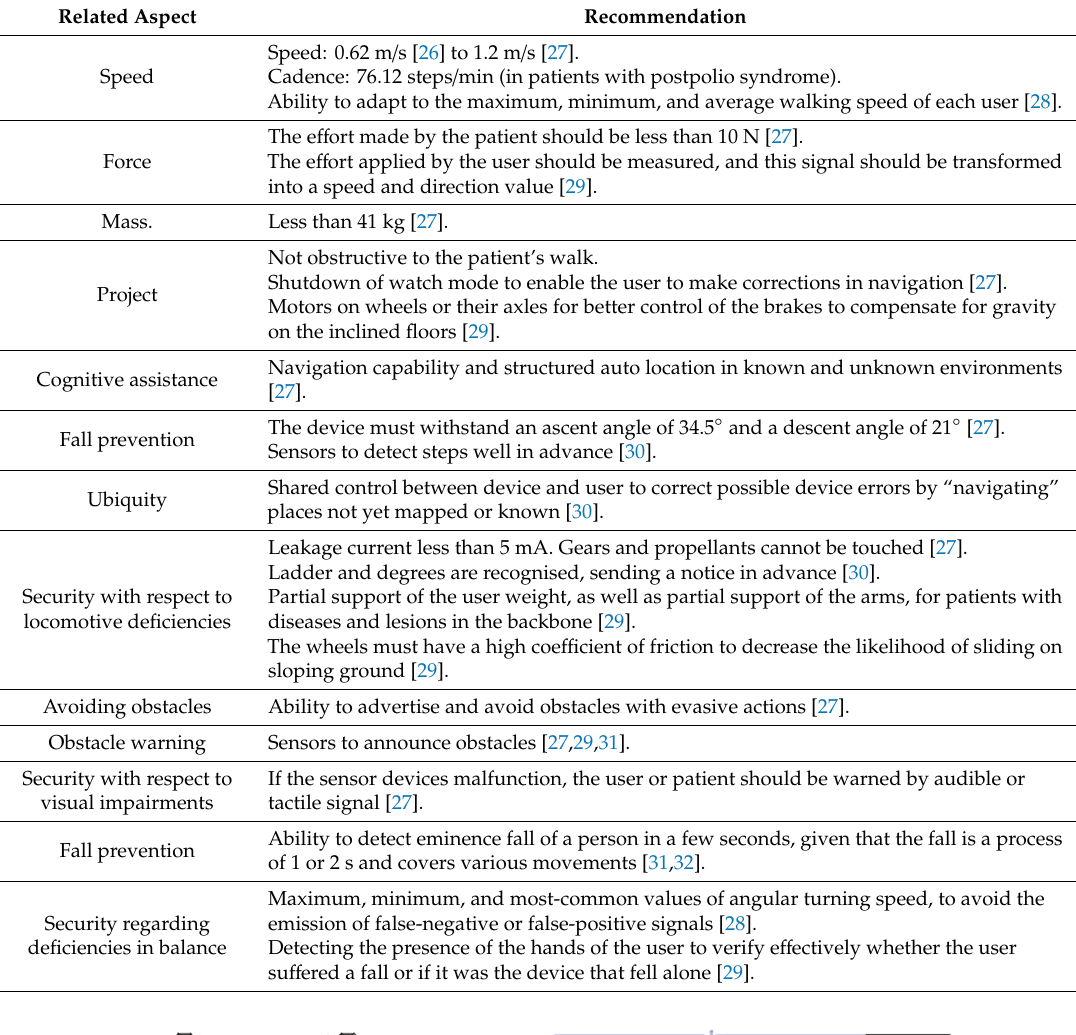
Table 1. Compilation carried out by Rivero [19] of recommendations of scientific articles for the boundary conditions of related